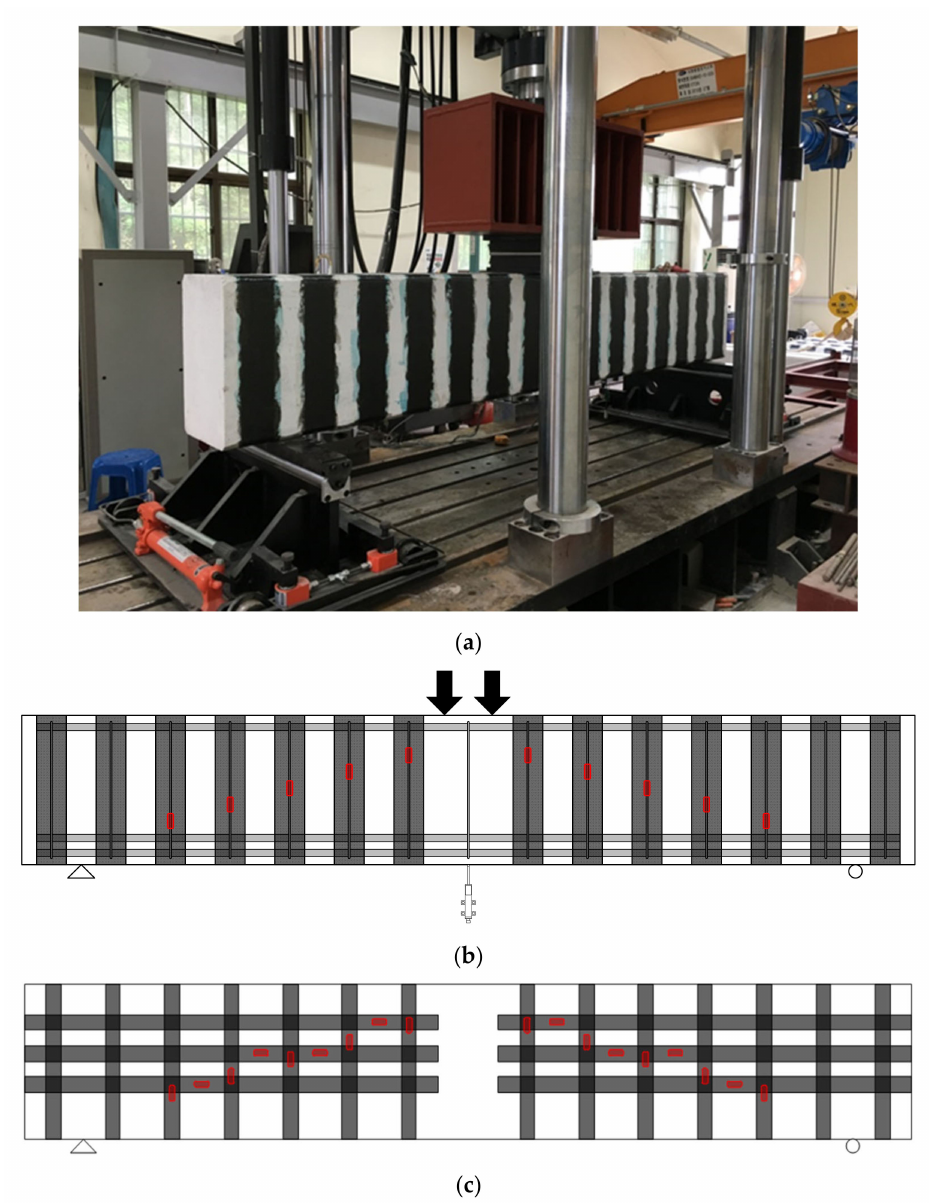
Figure 4. Test setup and schematic representation of LVDTs and strain gauge locations: ( a ) test setup, ( b ) LVDTs and strain gauges in members with unidirectional layout, and ( c ) LVDTs and strain gauges in members with bidirectional